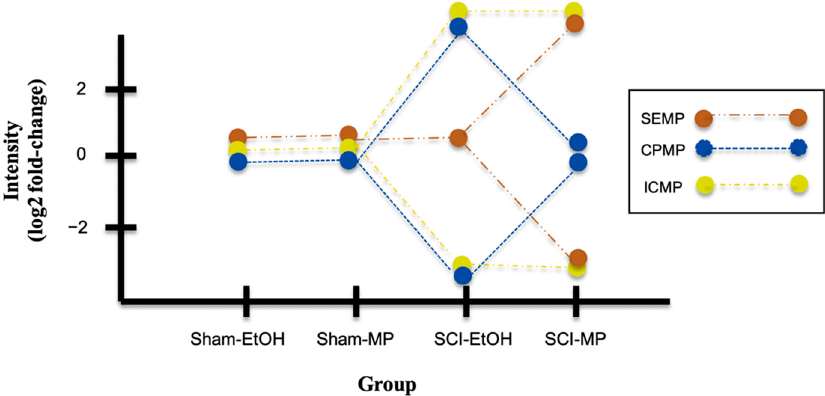
Figure 3. Expression profiles of three gene classes in four groups of MP experiment. Table 2 . Significancy table of three gene classes against four differentially expressed gene sets.